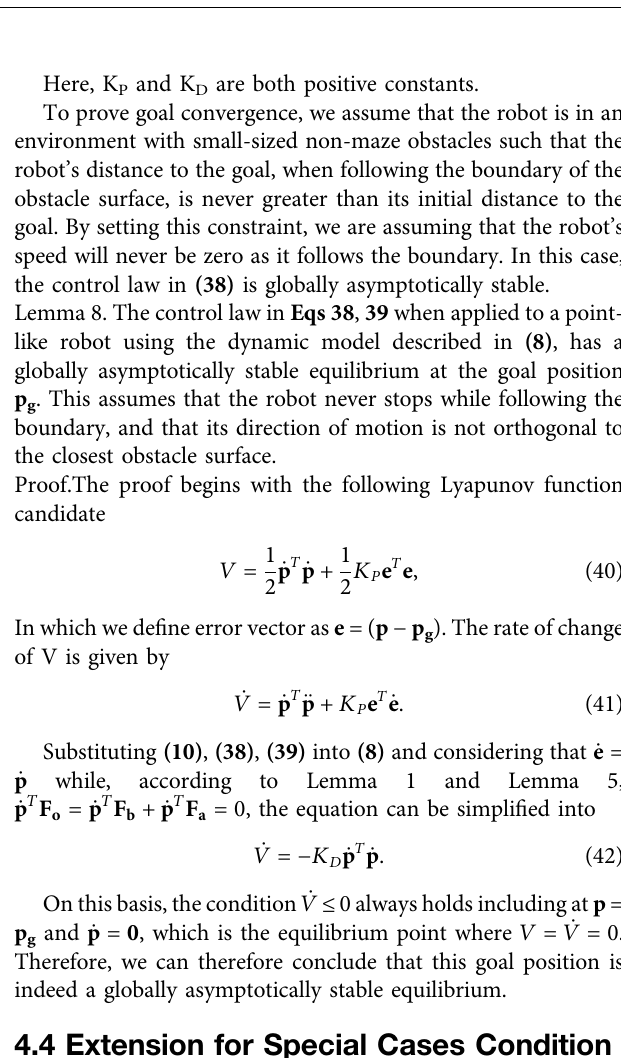
FIGURE 5 | Three possibilities of a robot in the vicinity of a smooth concave obstacle: (A) the case where κ < 1 κ > 1 r